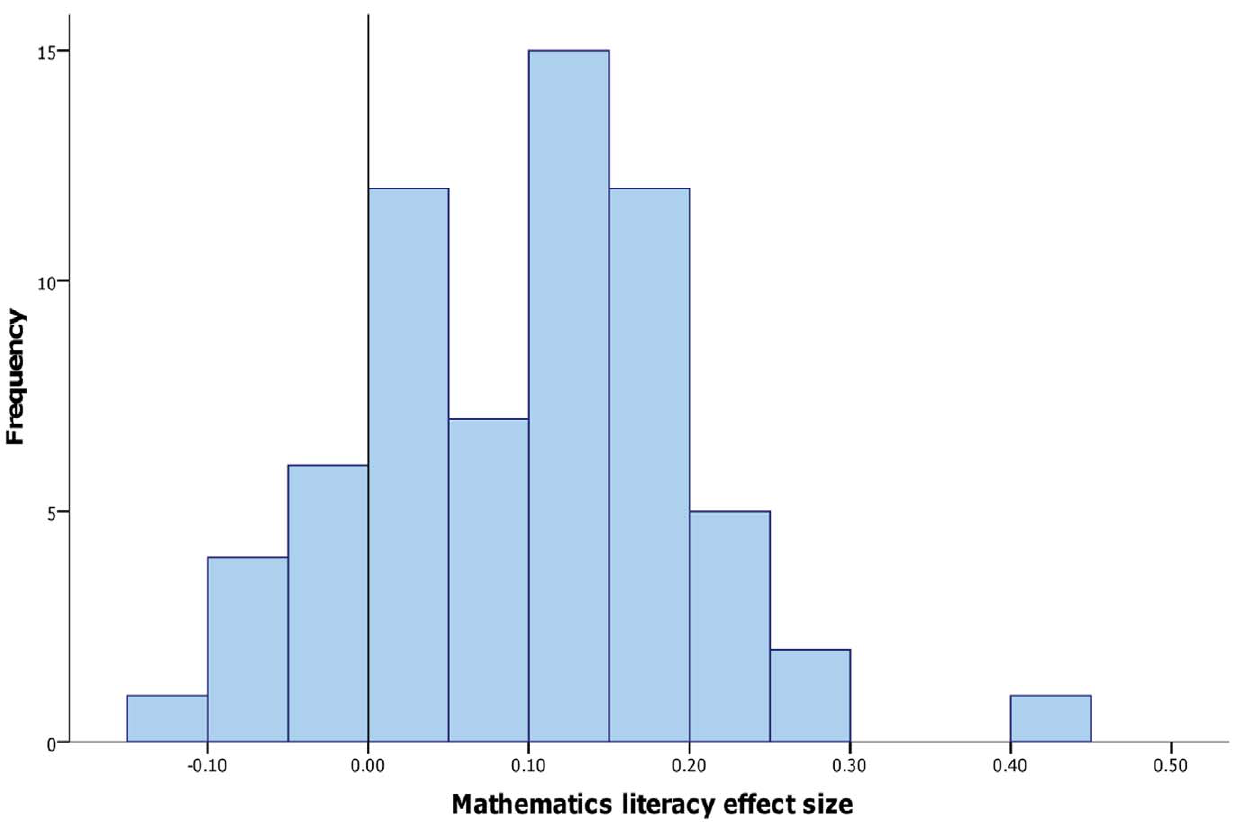
Figure 2. Histogram of gender difference effect sizes in mathematics literacy across OECD nations.